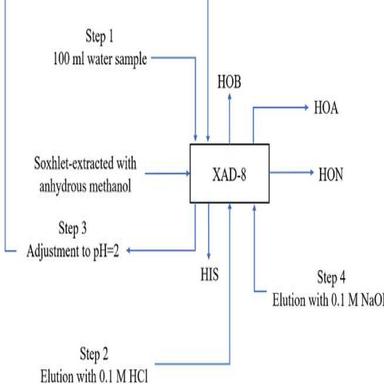
Schematic diagram of the procedure for fractionation procedure. HOB, hydrophobic bases; HOA, hydrophobic acids; HON, hydrophobic neutrals; HIS, hydrophilic substances.